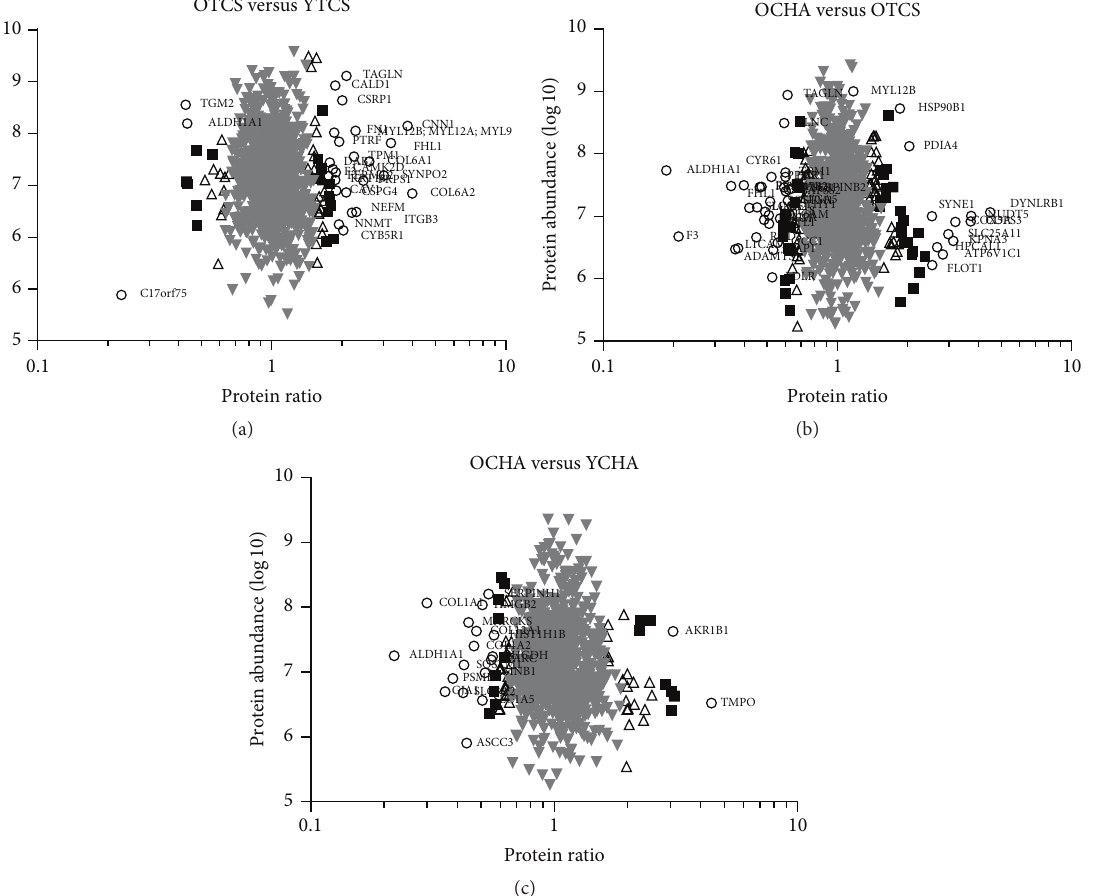
Figure 4: The normalized heavy- and light-labeled protein ratios plotted against total peptide intensities. The distribution of proteins identified is lower at higher abundance, confirming that protein quantification is more accurate. The data points are colored based on their significance 𝐵 calculated using software Perseus where the gray and black triangles represent 𝑃 value > 0.05 , squares 𝑃 value < 0.01 , and circles 𝑃 value < 0.001 . Abundant protein ratios for (a) OTCS H versus YTCS L , (b) OCHA L versus OTCS H , and (c) OCHA L versus YCHA H